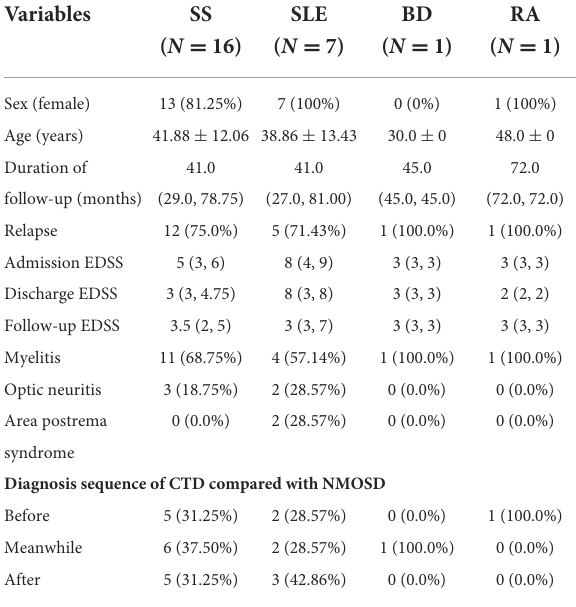
TABLE 1 Demographic and clinical characteristics in patients of first-attack NMOSD with CTD.